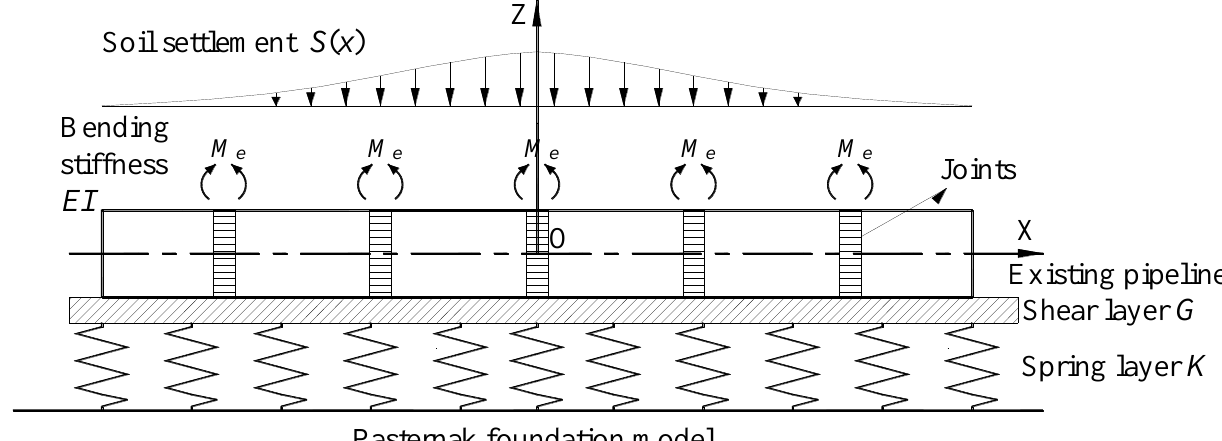
Figure 2. Calculation model of subgrade reaction analysis.